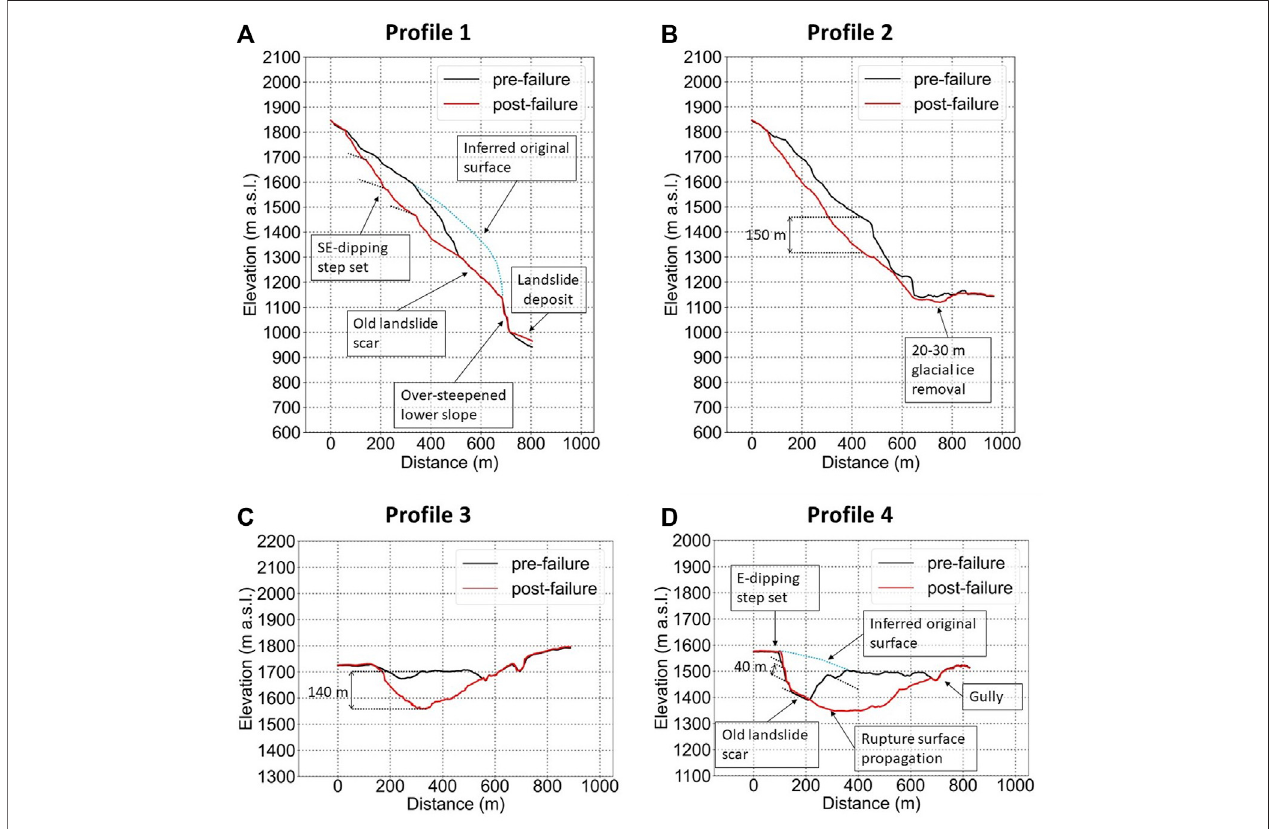
FIGURE4 | Overview ofthe pro fi le analysis. In (A) (pro fi le 1), note thesteps inthe upper, post-failureslopesurface, and the inferred pro fi le before the old landslide. In (B,C) (pro fi les2and3)thethicknessofthelandslideandtheglaciericeremovalaredisplayed.In (D) (pro fi les4)thesteppedsurfaceformingtheboundariesoftheolder landslide in the pre-failure slope topography is